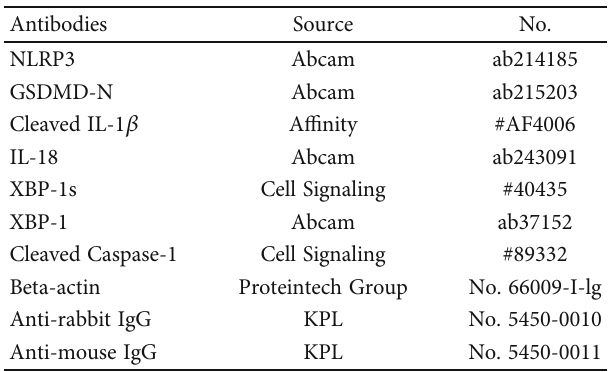
Table 1: Antibody speci fi